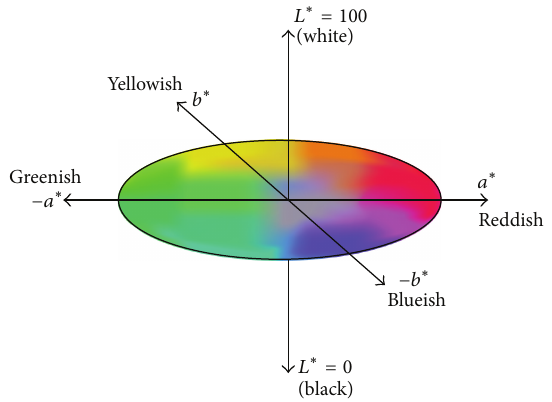
Figure 1: CIELab color